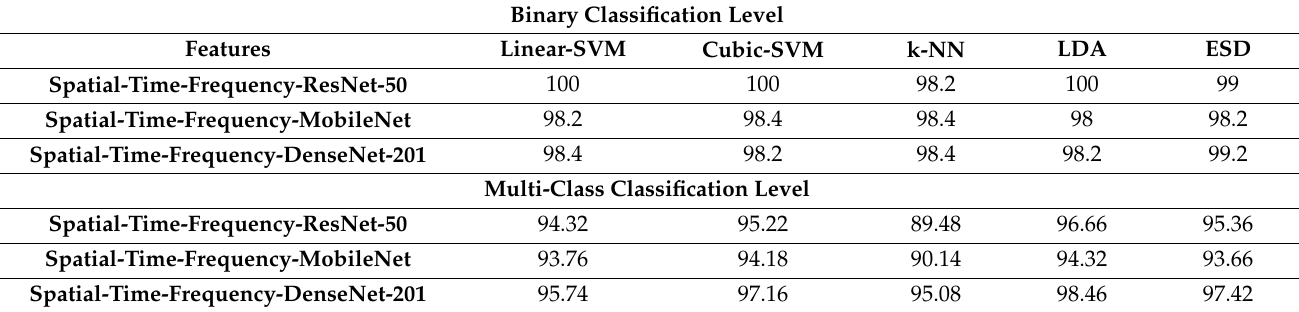
Table 8. The classification testing accuracy (%) for the five classifiers used in MB-AI-His trained using spatial-time-frequency DL features extracted from the three